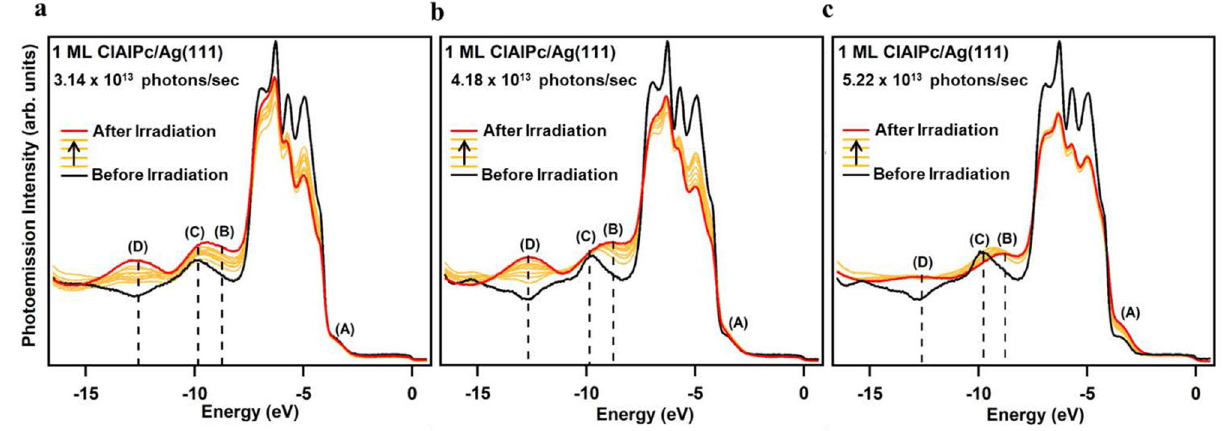
Figure 2. Time-dependent photoemission spectra of 1-ML ClAlPc on Ag(111) at photon flux of ( a ) 3.14 × 10 13 photons/sec, ( b ) 4.18 × 10 13 photons/sec, and ( c ) 5.22 × 10 13 photons/sec. The energy positions of the Cl-down, Cl-up, and anomalous molecular-energy-state peak are indicated with the black dashed line. The consecutive EDCs denoted by the orange color are from the 8 sweeps of the spectrums during irradiation.